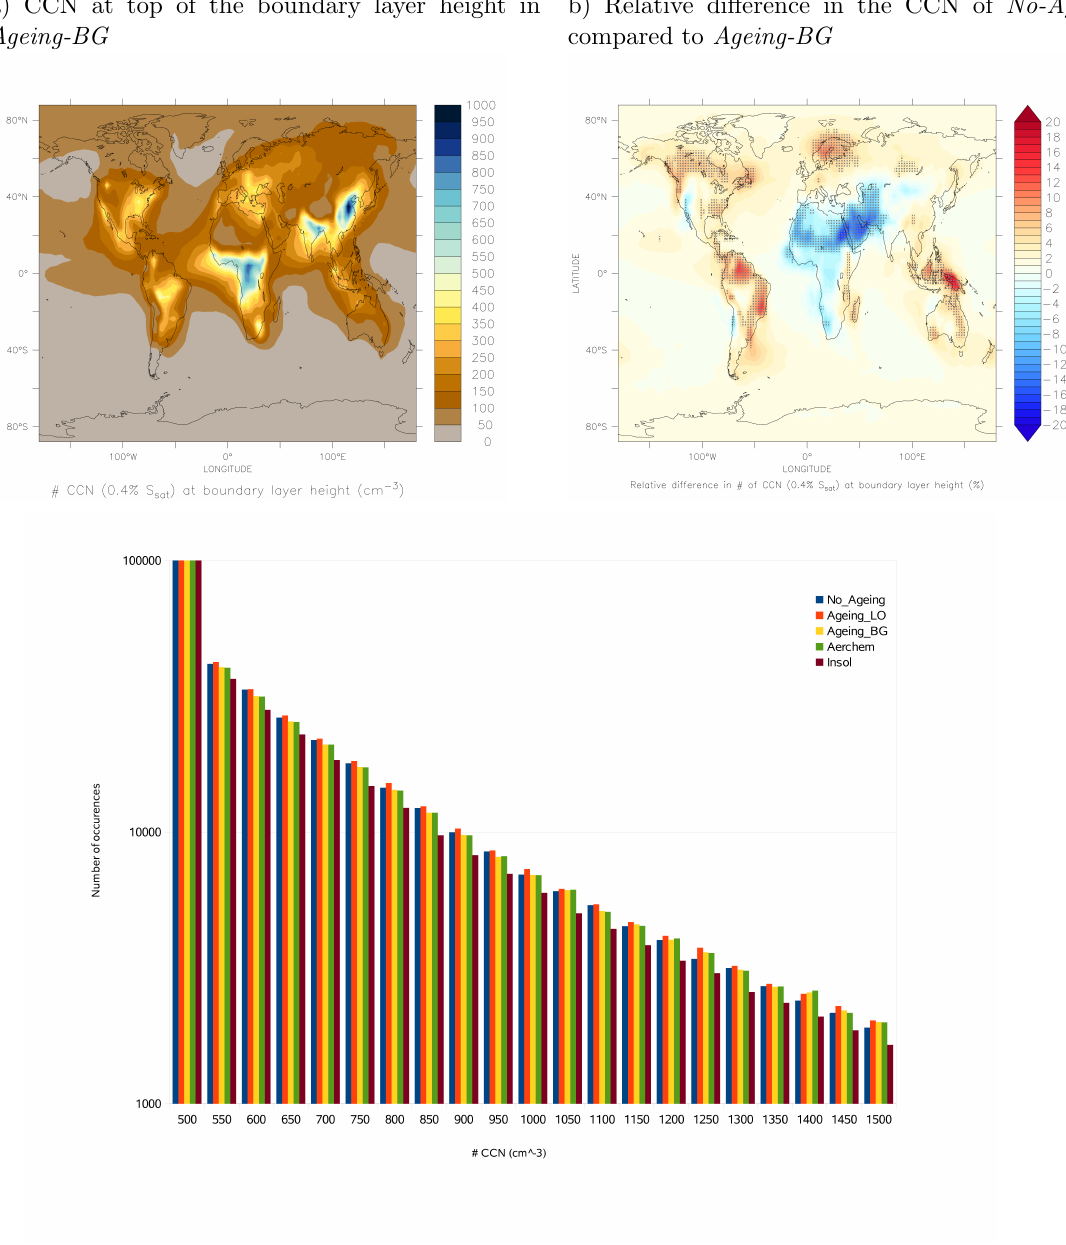
Fig. 9. Annual averages of the total CCN at the top of the boundary layer height calculated assuming 0.4% supersaturation. (a) shows the absolute values (in #cm − 3 ) for the Ageing-BG simulation. (b) shows the relative difference to the No-Ageing simulation. The high statistical significance in the differences is marked by the overlayed pattern. The panel in the lower row represents a histogram for the five simulations taking only high CCN values ( > ∼ 500cm − 3 ) into account. The different colours represent the respective